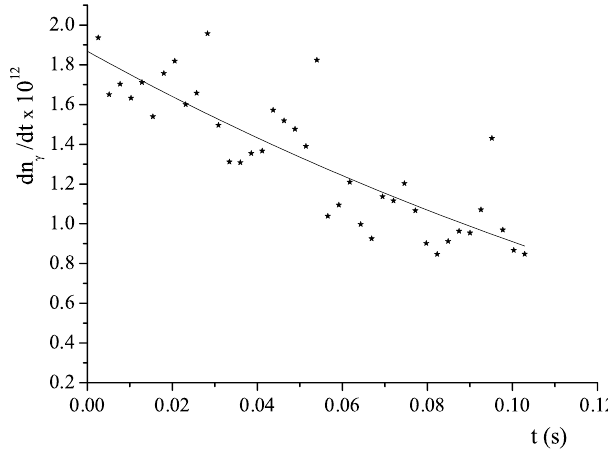
FIG. 7. Intensity of x rays vs time. The number of electrons per (cid:1) 3 : 2 (cid:14) 10 10 ( 0 : 5 nC = bunch ), the number of bunch is n e